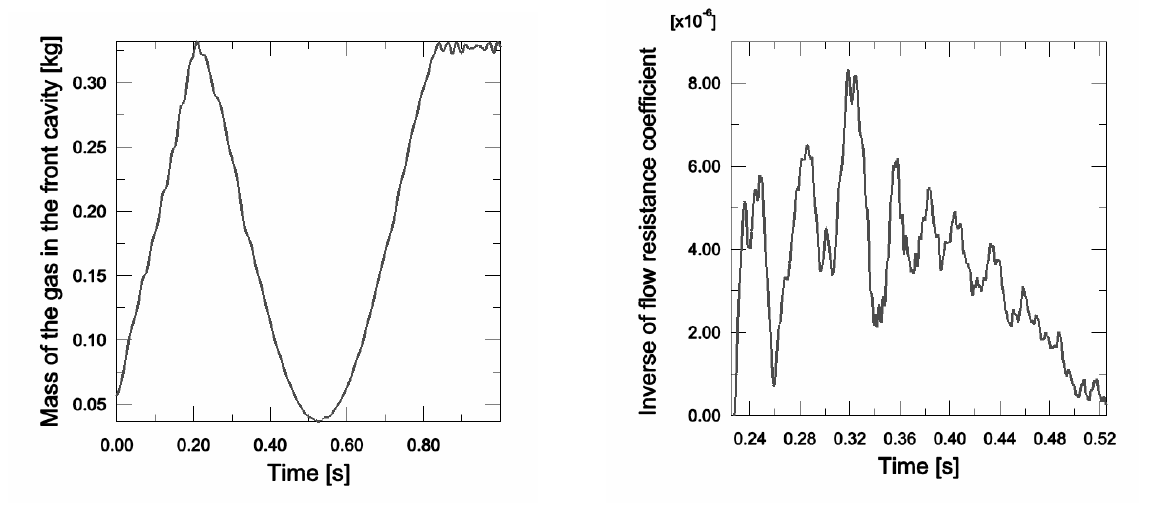
Fig. 12. Active strategy of stress minimisation: a) mass of the gas in the cavity, b) inverse of flow resistance coefficient during compression stage of impact.